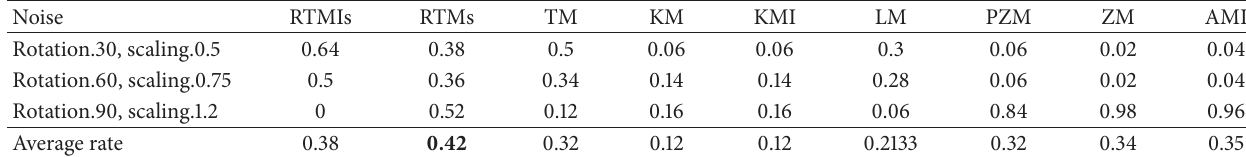
Table 4: Recognition rates of different moments about logos with rotation and scaling.